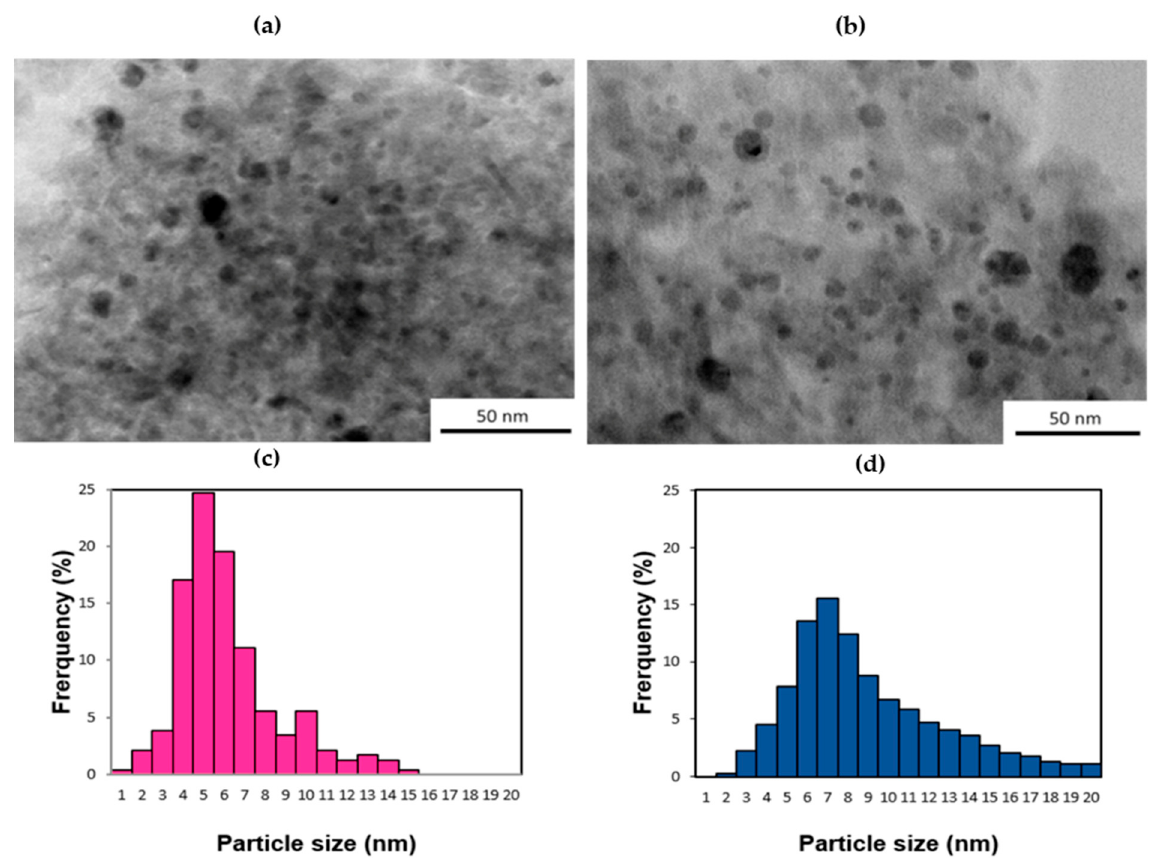
Figure 2. Transmission electron microscopy (TEM) images of: ( a ) of red(400 °C)-Pd/ γ -Al 2 O 3 and ( b ) red(600 °C)-Pd/ γ -Al 2 O 3 catalysts. Pd particle size distribution for: ( c ) red(400 °C)-Pd/ γ -Al 2 O 3 and ( d ) red(600 °C)-Pd/ γ -Al 2 O 3 catalysts.